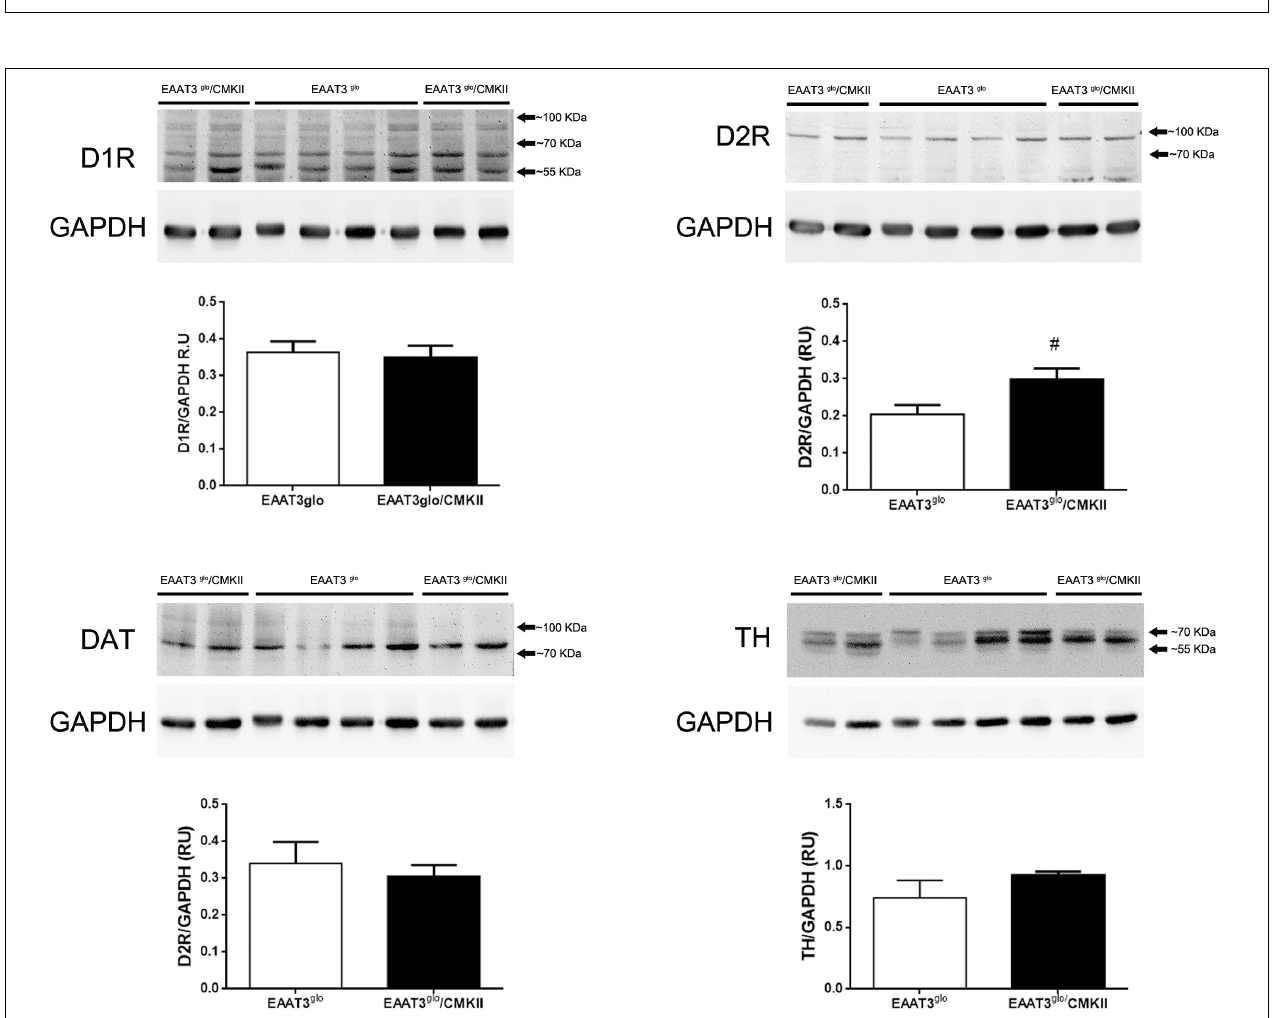
FIGURE 5 | Increased expression of DA D2R in the striatum of EAAT3 glo /CMKII mice. Thirty micrograms of striatal protein extracts was processed for the immunodetection and quantification of proteins of the dopaminergic system. Western blot images show the individual bands of protein samples obtained from four mice per group; protein band quantification is depicted below. # p = 0.0286, according to unpaired t -test. EAAT3 glo n = 4; EAAT3 glo /CMKII n = 4.